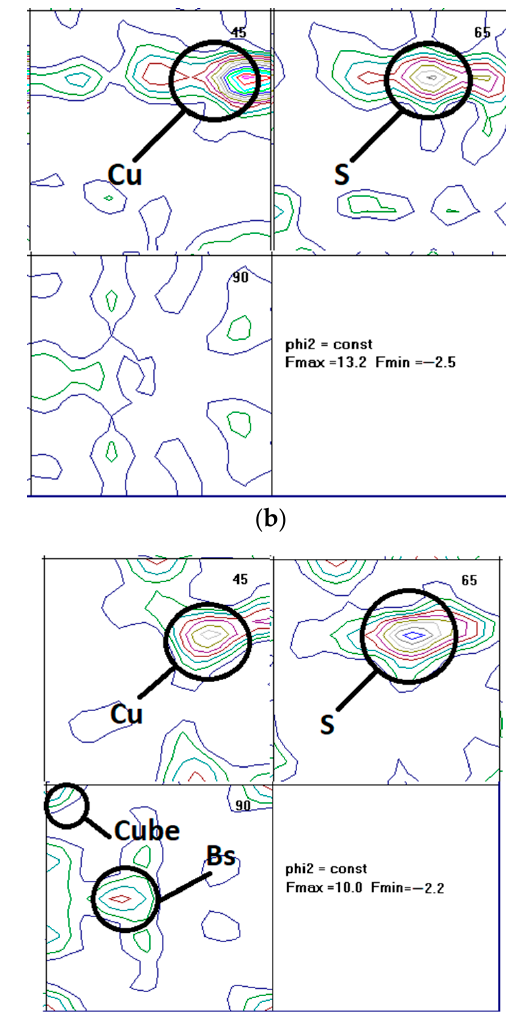
Figure 4. Ideal texture orientations on ODF .